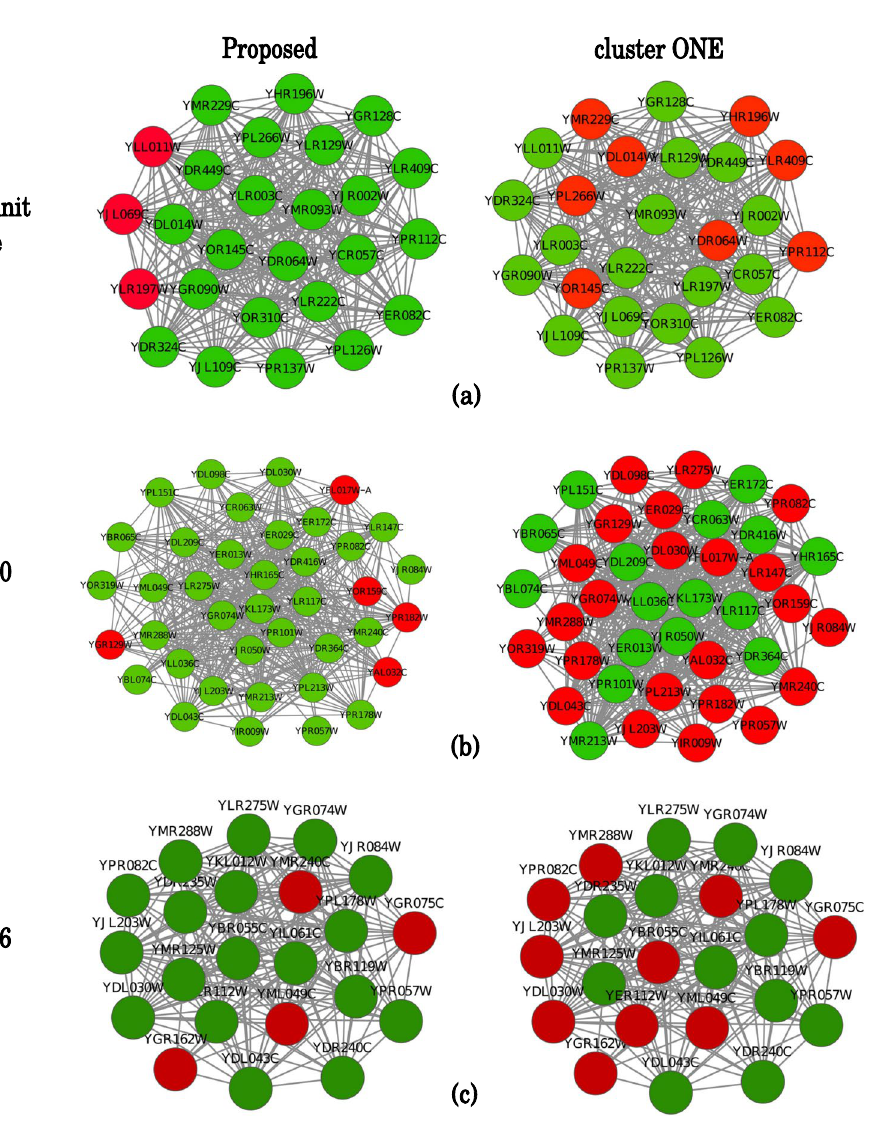
Figure 5. Figure shows visualization of three benchmark complexes: ‘Small subunit processom’ (panel- a),‘complex-435’ (panel-b) and ‘complex-410’ (panel-c) as detected by the proposed method and clusterONE. In the benchmark complexes, green nodes are predicted by the methods, while red nodes are not